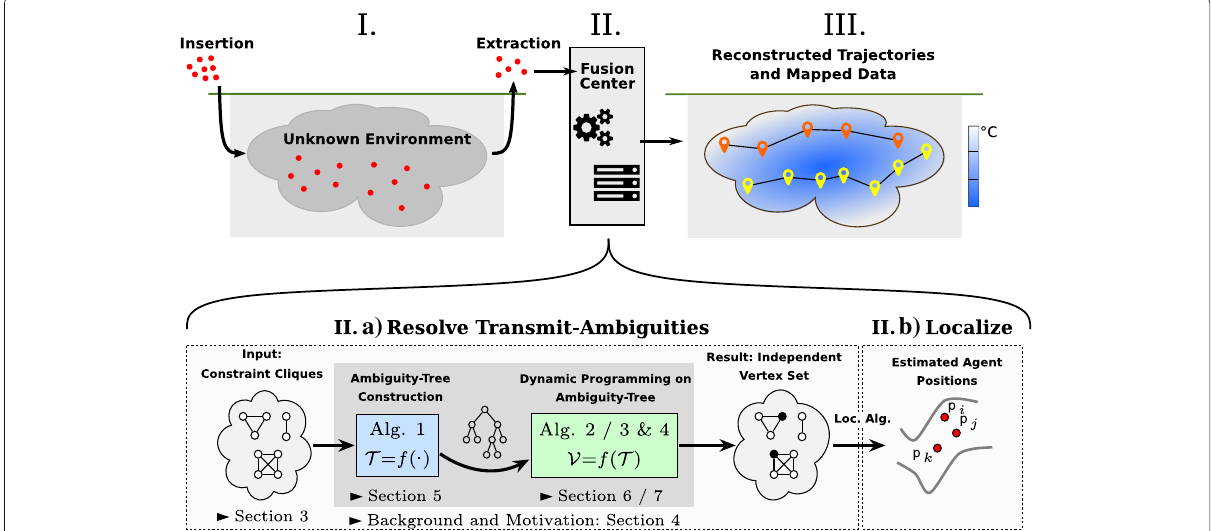
Fig. 1 Illustration of the exploration procedure. In step I, agents (visualized in red) are introduced into an unknown environment and perform environmental and distance measurements for mapping and localization, respectively. The agents are carried by the fluid in the environment. Then, the agents are extracted from the environment, and their data are used by a fusion center (step II) to compute the agents’ trajectories (illustrated for two agents). The steps executed by the fusion center for this purpose are as follows: (a) resolve the transmit ambiguities, e.g., with the presented algorithms, and (b) perform positioning using classical localization algorithms. In step III, the environmental measurements and estimated trajectories are used to compute, e.g., the temperature profile of the